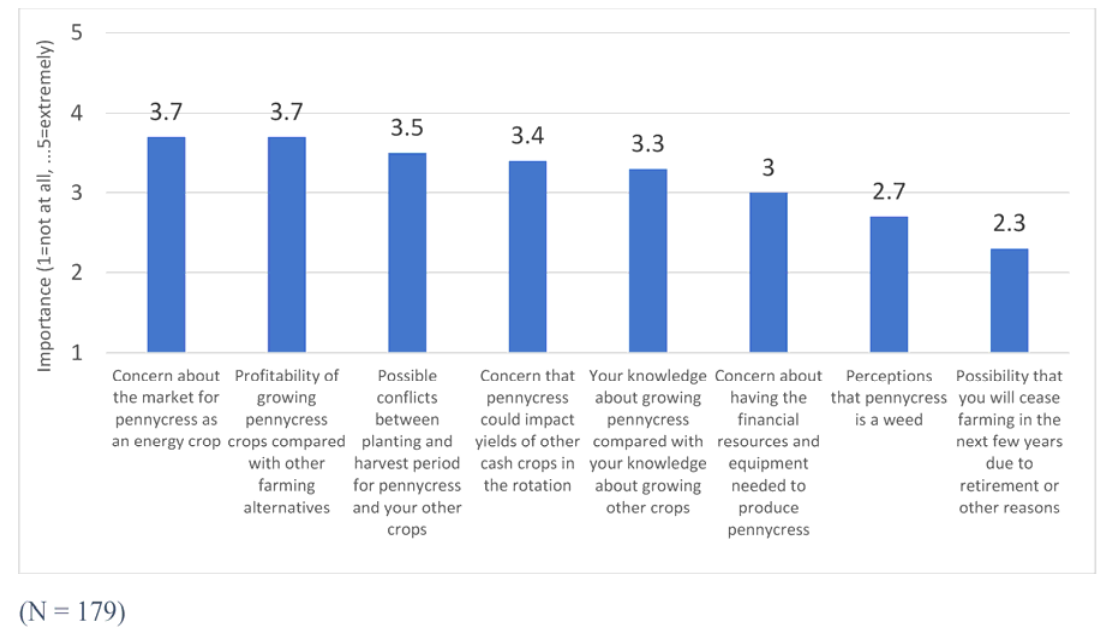
Figure 3. Importance of potential concerns/barriers on decision to grow pennycress among row crop farmers in seven US states.